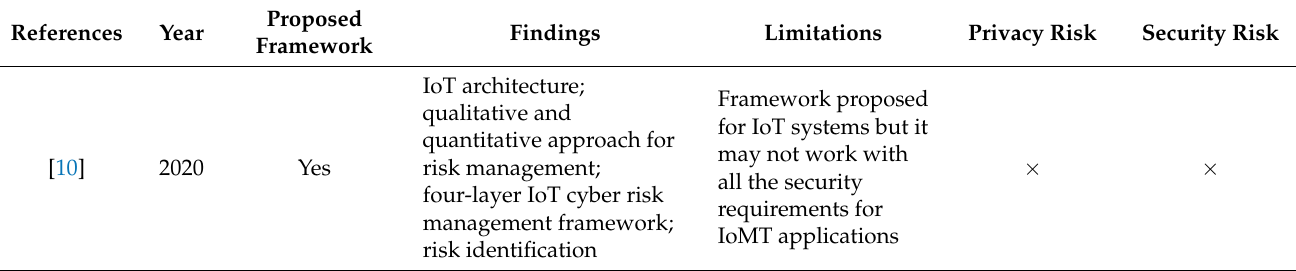
Table 5. Summary of literature